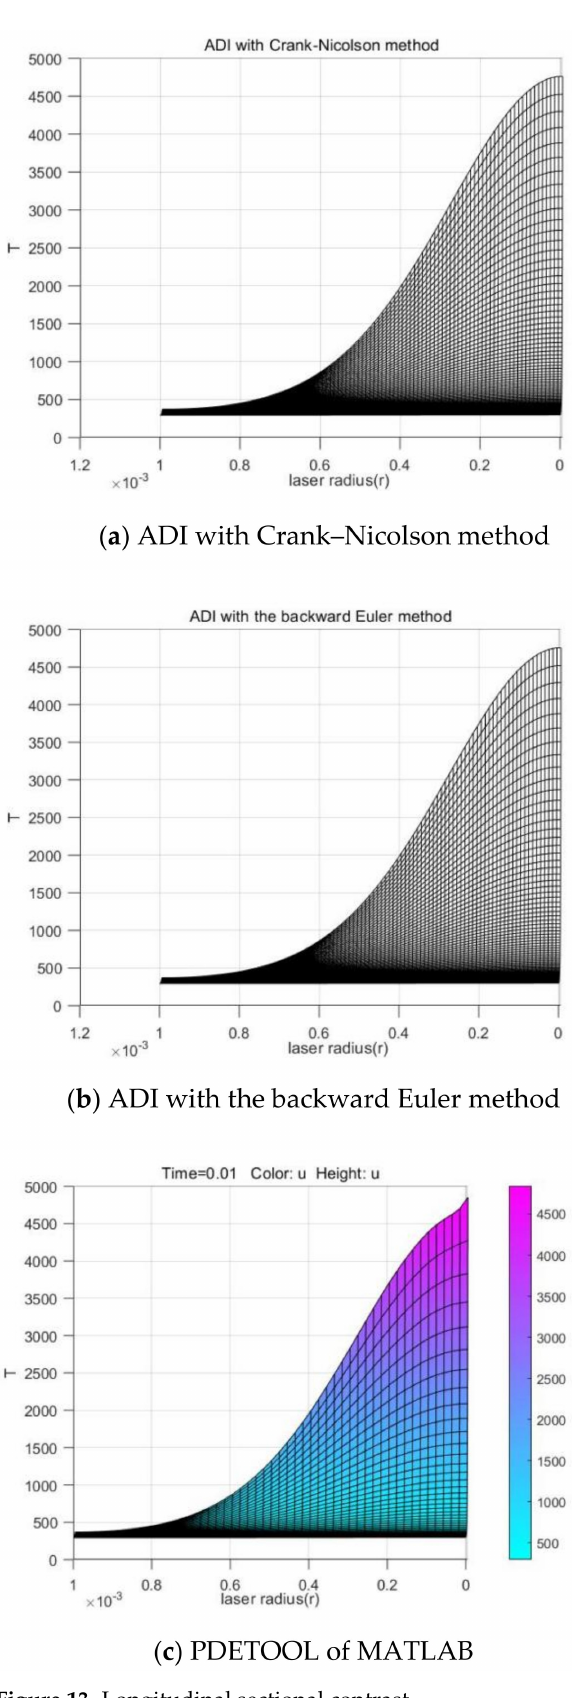
Figure 13. Longitudinal sectional